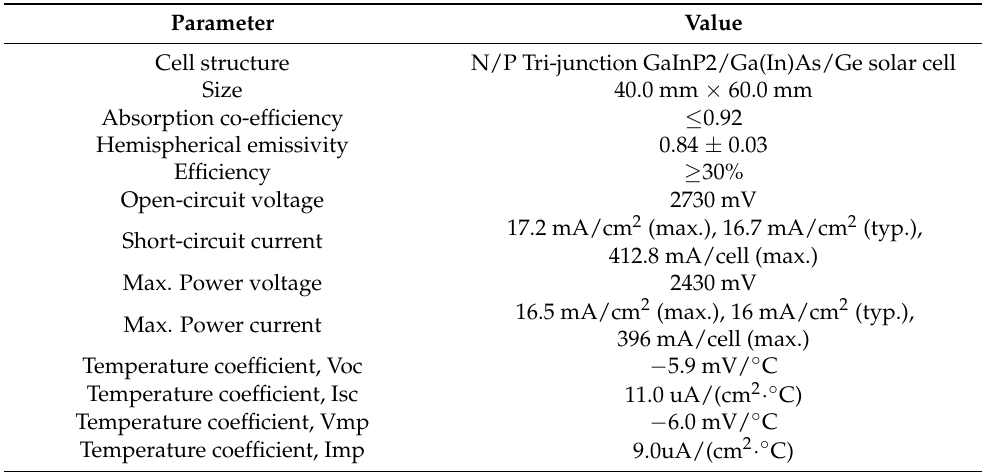
Table 1. Solar cell parameters.